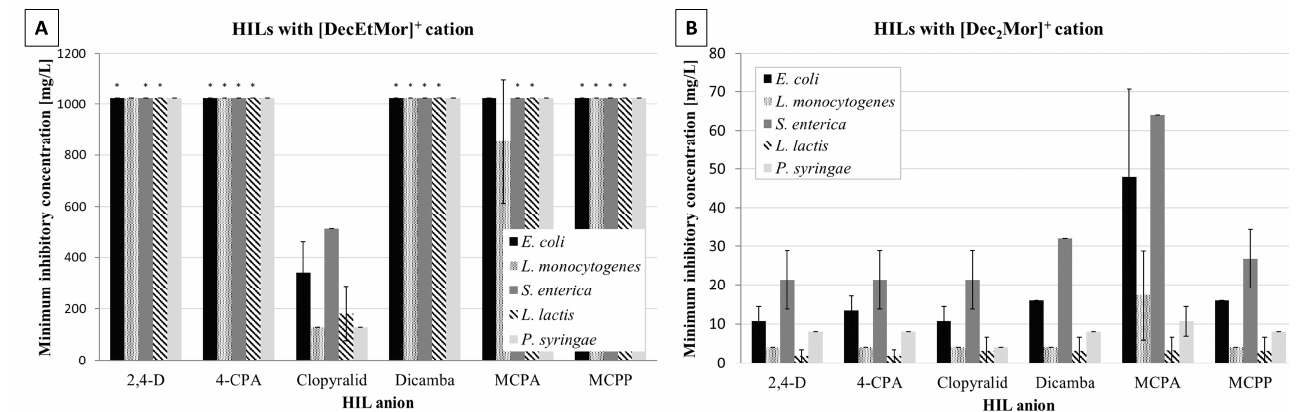
Figure 3. Mean minimum inhibitory concentration MIC [mg/L] ± SD of HILs with either [DecEtMor] + cation ( A ) or [Dec 2 Mor] + cation ( B ) for bacterial hosts: E . coli , L. monocytogenes , S. enterica , L . lactis , P. syringae ; * No antimicrobial effect observed at 1024 mg/L concentration. Note the ordinate scale differences between the two